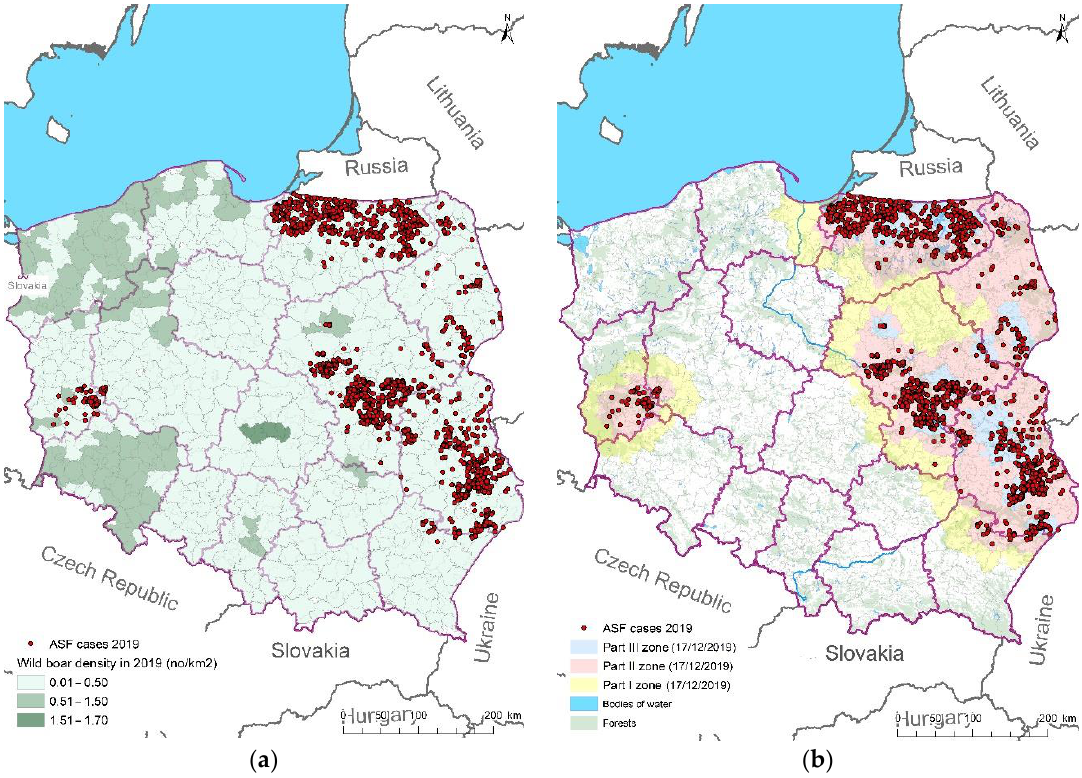
Figure 2. ASF cases in wild boar populations in Poland during the 2019 year. ( a ) map shows wild boar density, while ( b ) map presents ASF zones (at the end of the year 2019) and forests.